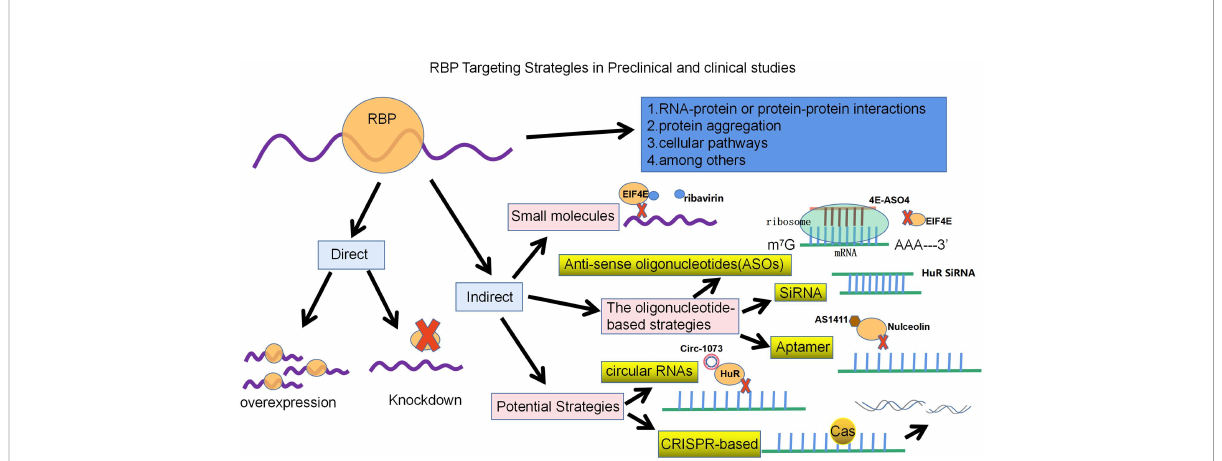
FIGURE 3 With the development of Clip-sequencing, a technique to identify genome-wide RNA binding motifs in vivo . These strategies may involve RNA- protein or protein-protein interactions, cellular pathways and protein aggregation, among others. Direct therapeutic strategies revolve around knocking down or overexpressing speci fi c RBPs, while indirect approaches, on the other hand, include the use of small molecules, oligonucleotide-based strategies (ASO, SiRNA, Aptamer) and other potential strategies. The schematic diagram lists some of the RBPs that have made breakthroughs in breast cancer treatment strategy